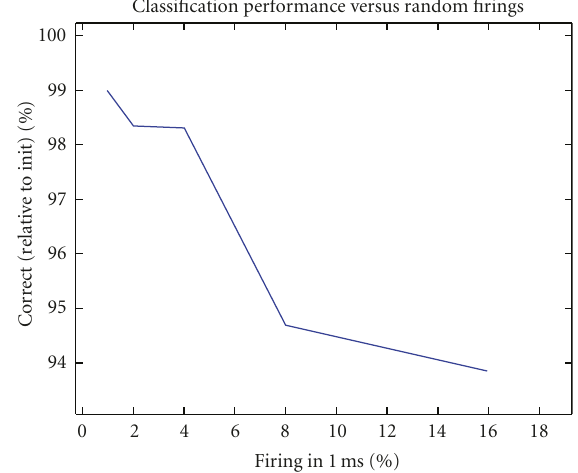
Figure 11: LM-HMM cluster iterations (Two classes, k = 4).